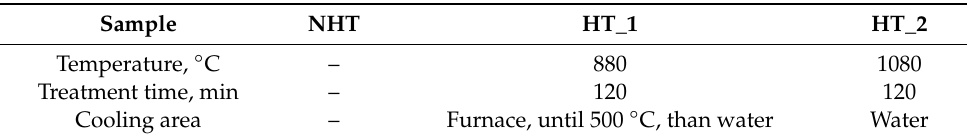
Table 2. Heat Treatment